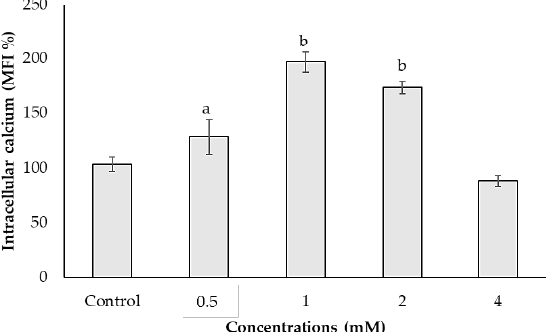
Figure 3. Effects of ACE on intracellular calcium in SH-SY5Y cells after 24 h of treatment. Data are presented as mean ± SD; and, statistically significant changes are indicated as a: p < 0.05 and b: p < 0.01.